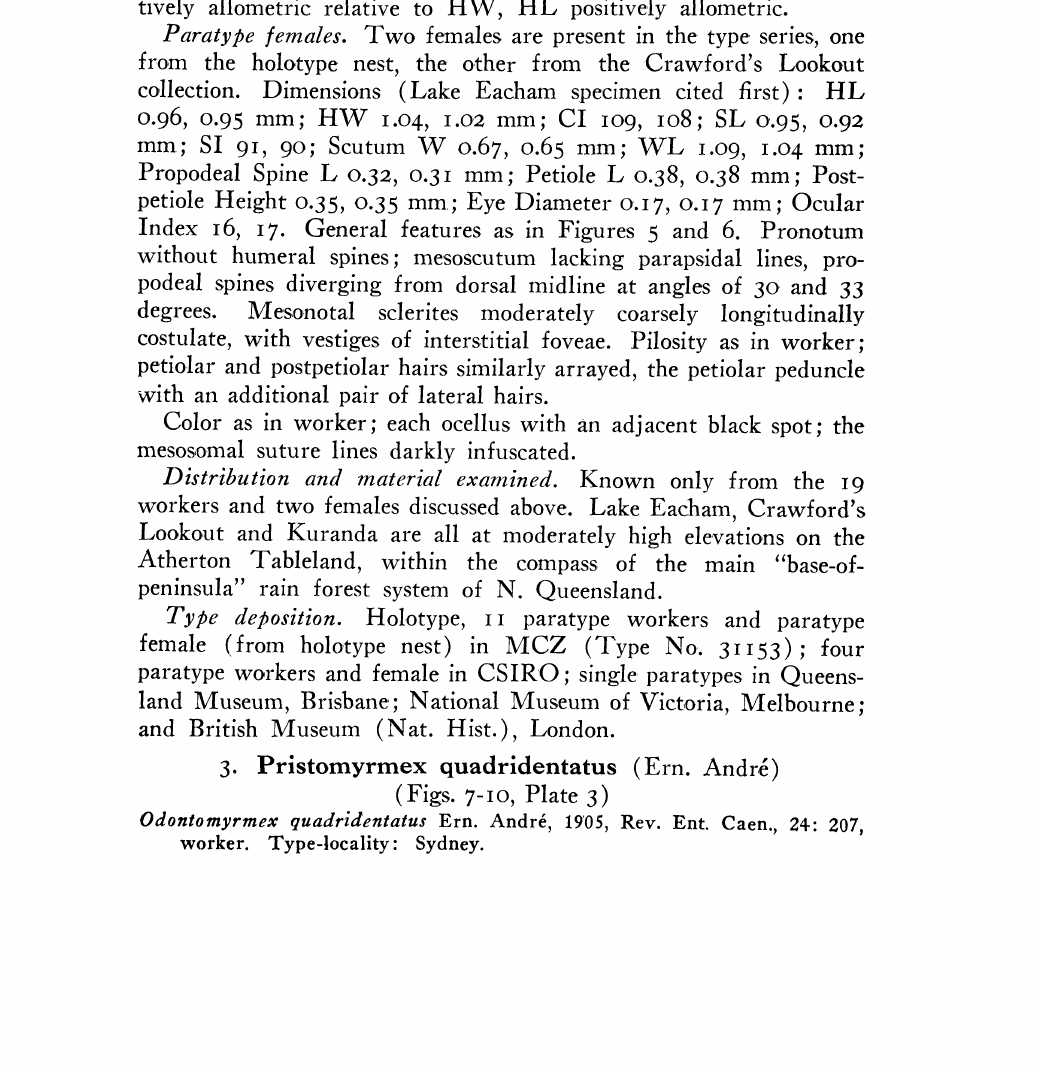
Figs. 7- o, Plate. 3 Odontomyrmex quadridentatus Ern. Andr6, 19’05, Rev. Ent. Caen., 24: